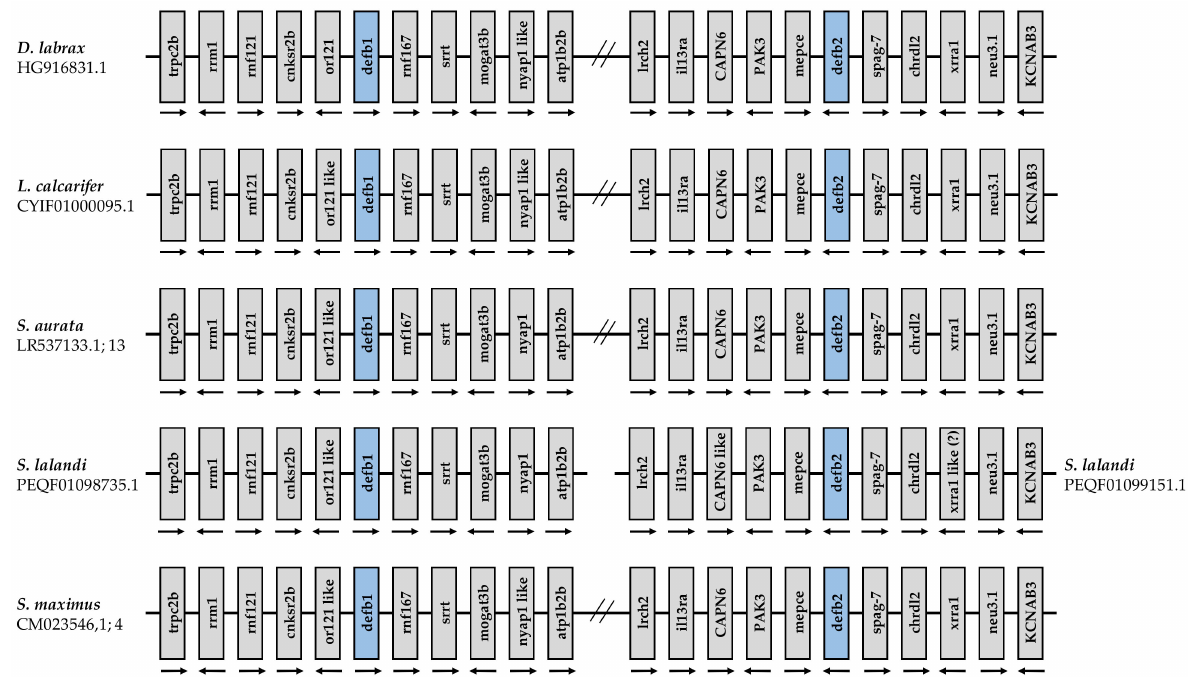
Figure 7. Analysis of beta-defensin loci in the European sea bass ( D. labrax , location HG916831.1), Barramundi perch ( L. calcarifer , location CYIF01000095.1), Gilthead seabream ( S. aurata , location LR537133.1; 13), Yellowtail amberjack ( S. la- landi , locations PEQF01098735.1 and PEQF01099151.1 for beta-defensins 1 and 2, respectively) and Turbot ( S. maximus , location CM023546.1; 4). Analysis was performed using sequences available in the Ensembl genome browser 103, and the corresponding accession numbers of each gene are described in Table S2. S. lalandi xrra1 : incomplete